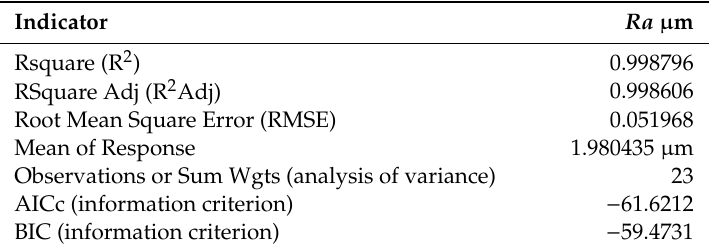
Table 5. Summary of the fit parameter Ra .